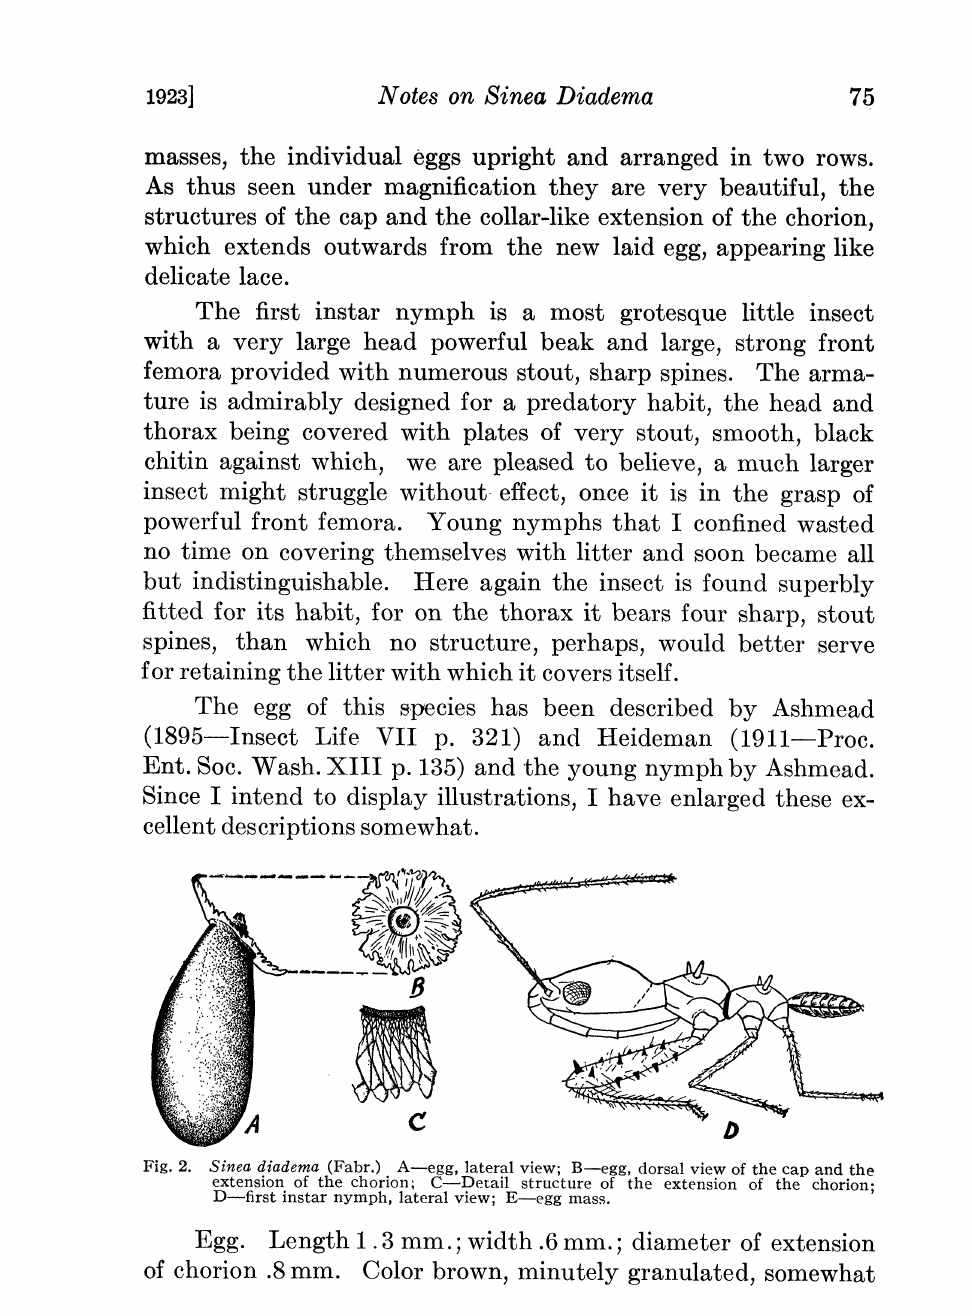
Fig. 2. Sinea diadema (Fabr.) A--egg, lateral view; Bqegg, dorsal view of the cap and the extension of the chorion; C--Detail structure of the extension of the chorion; D--first instar nymph, lateral view; E--egg mass. Egg. Length 1.3 mm. width .6 mm. diameter of extension of chorion .8 mm. Color brown, minutely granulated,